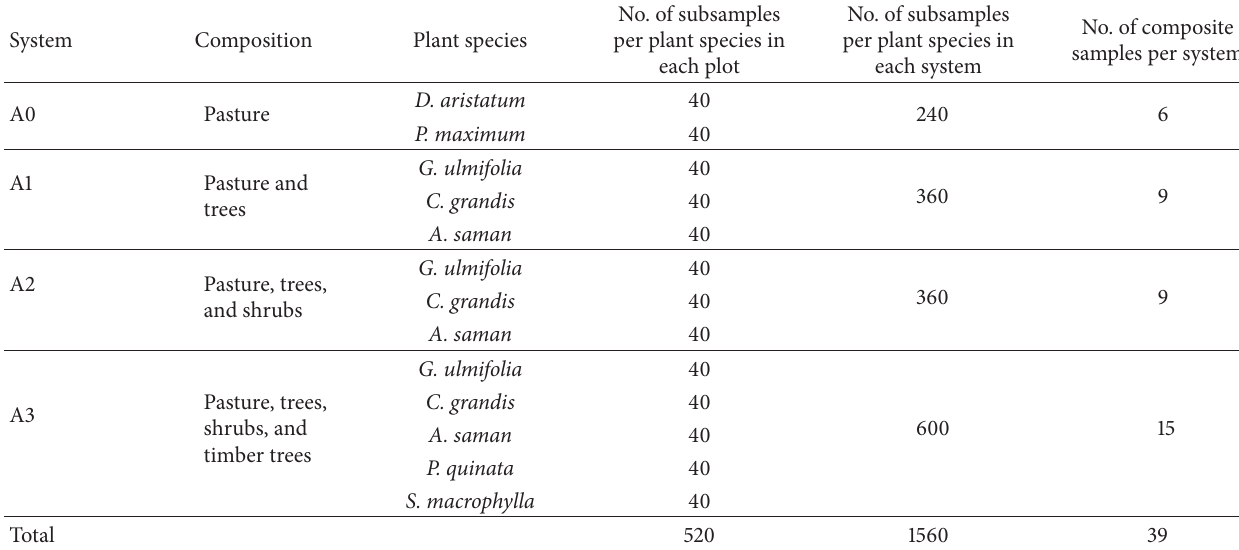
Table 2: Number of soil subsamples collected and composite samples associated with plant species in silvopastoral systems in the Sinu River Valley,